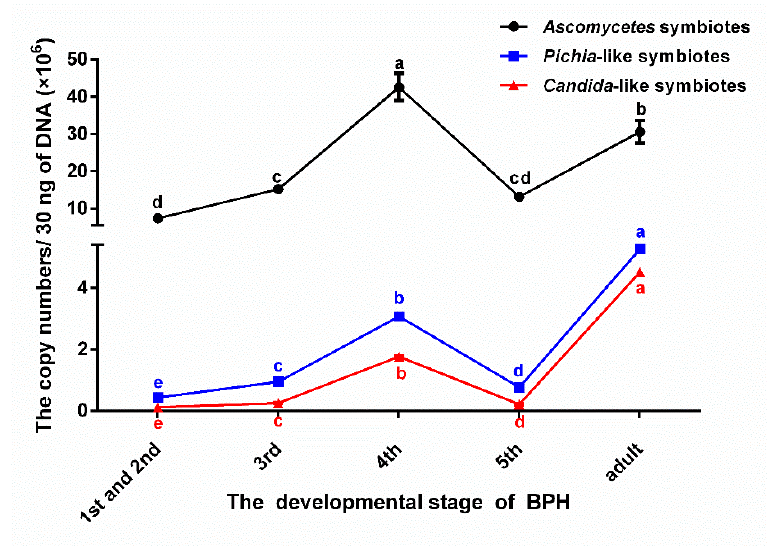
Figure 2. The copy number (×10 6 ) of three dominant YLS of BPH in the different developmental stages. The 1st and 2nd, 3rd, 4th, 5th represent the instar nymph stage; adult represents newly emerged female adults. There were significant differences between different lowercase letters ( p ≤ 0.01, one-factor ANOVA and Tukey’s multiple comparisons).